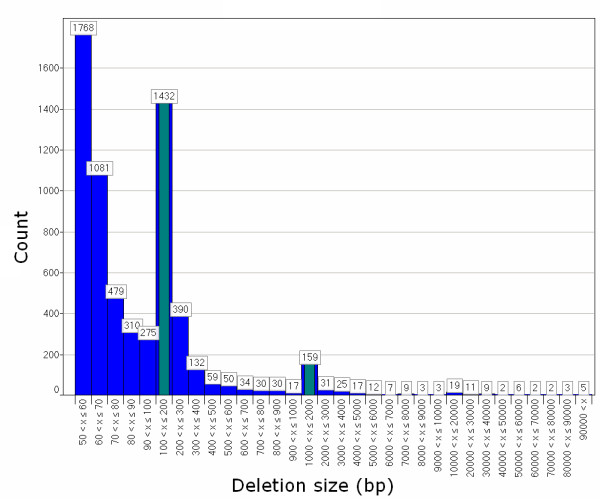
Size distribution of deletions detected by BreakDancer and Pindel. With increasing deletion size, the frequency decreases exponentially. The exceptions are for the bars (green) that correspond to SINE and LINE elements.